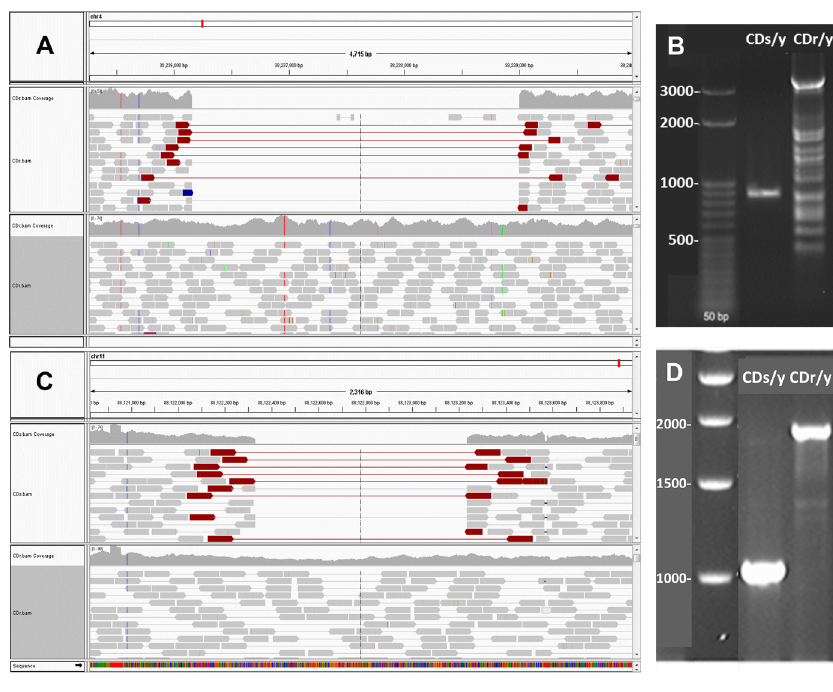
Figure 6. Large rare deletions found on RNO4 (panel A) and RNO11 (panel C). Each panel shows the reads and coverage tracks that allowed detection of large rare dele- tions in CDs/y but not in CDr/y in both chromosomes. Panels B and D demonstrate the difference in genomic DNA between the size of CDs/y and CDr/y on RNO4 and RNO11, respectively, on agarose